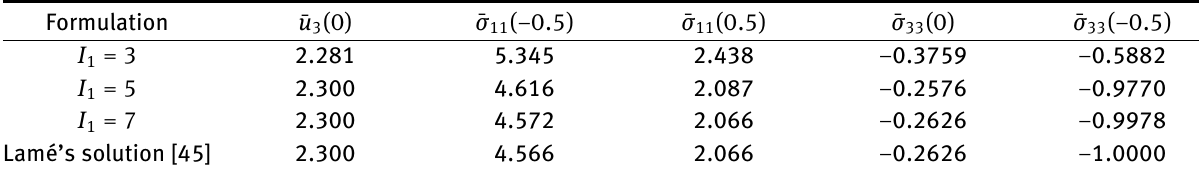
Table 4: Results for thick and thin spherical shells using a regular 64 × 1 mesh of SaSGeX4 elements. R / h